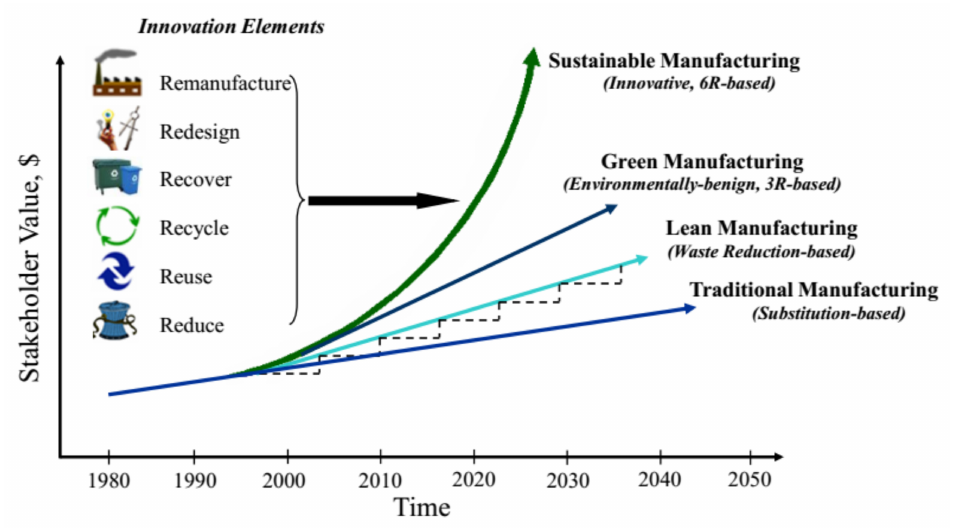
Figure 6. Evolution with the time of sustainable manufacturing, reprinted with permission from ref. [32]. Copyright 2010 CIRP, Published by Elsevier